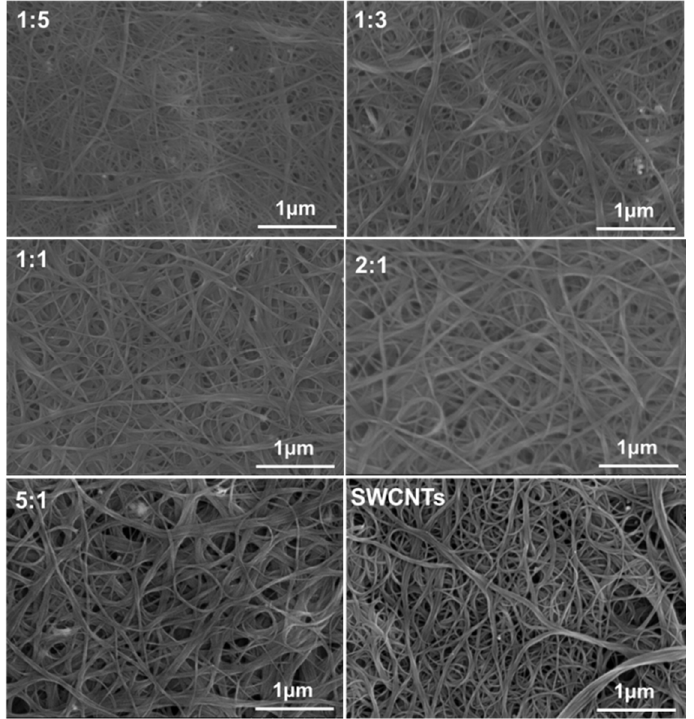
Figure 3. Scanning electron microscope (SEM) images of P1 / SWCNTs composite films with di ff erent amounts of SWCNTs.